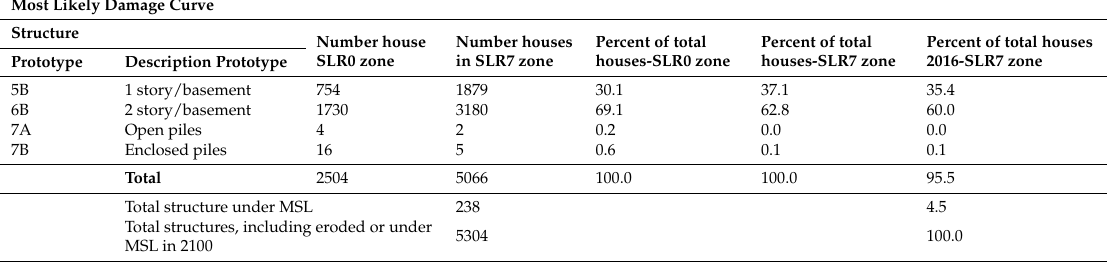
Figure 16. Location and type of structures for the Warwick, RI study area (upper panel). The lower panel shows the ability to resolve at the structure by structure level. Table 4. Number of structures total and damaged for Warwick, RI study area for various scenarios.